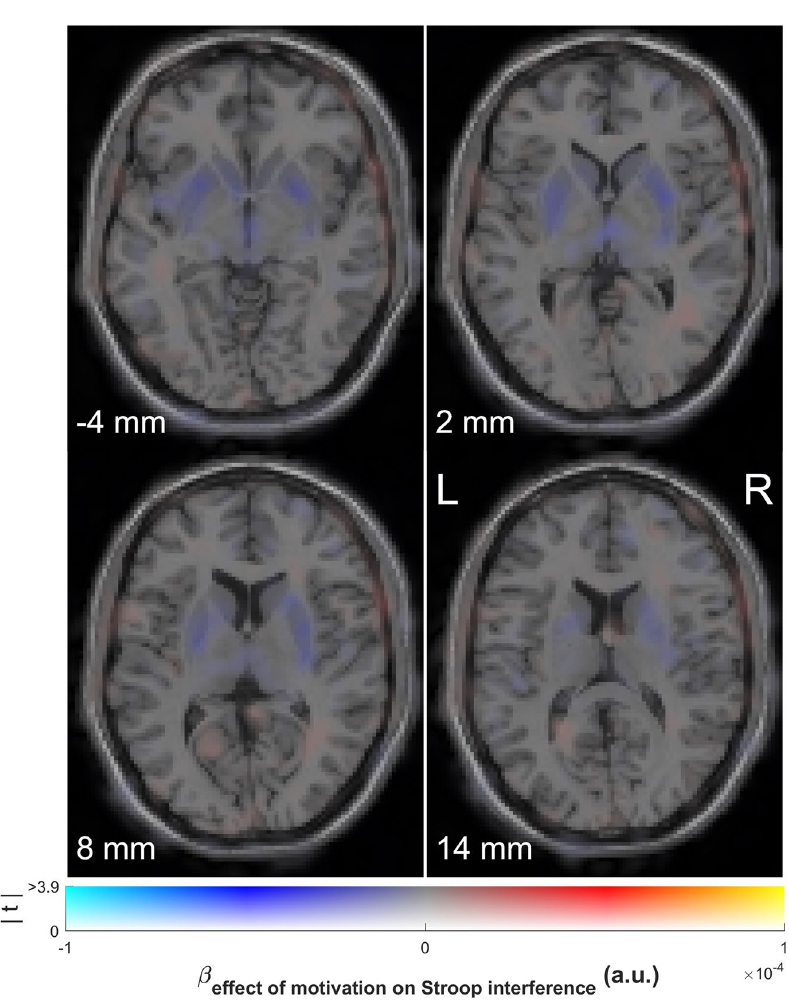
Figure 3. Association of baseline dopamine synthesis capacity with the effect of reward on Stroop interference on uninformed trials. Voxels showing a positive (red) or negative (blue) regression coefficient on the effect of a promised reward on Stroop interference in terms of response times on uninformed trials. Dual-coded and simultaneously displaying the contrast estimate ( x axis) and t values ( y axis). The hue indicates the size of the contrast estimate, and the opacity indicates the height of the t value. The z coordinates correspond to the standard MNI brain. No voxels survive p < 0.05 peak-level corrected (FWE) or p < 0.001 uncorrected. Plotted using a procedure introduced by Allen et al . 44 and implemented by Zandbelt 45